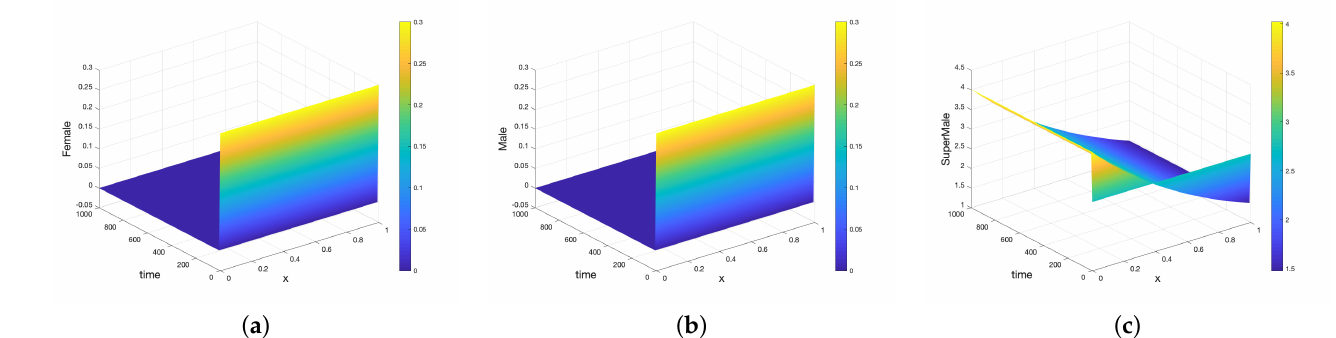
Figure 4. Simulation for scaled system (9)–(11) (see Appendix B) with f ( x ,0 ) = m ( x ,0 ) = 0.3 and s ( x ,0 ) = 2.75 and Neumann boundary conditions for both f and m and a mixed boundary condition for s . Here, χ = 0. ( a ) The increase in the initial amount of s results in finite time blow-up in f and in ( b ), m goes negative. ( c ) s reaches a non constant steady state. Simulation uses D = 1, γ = 0 and ρ = 18.